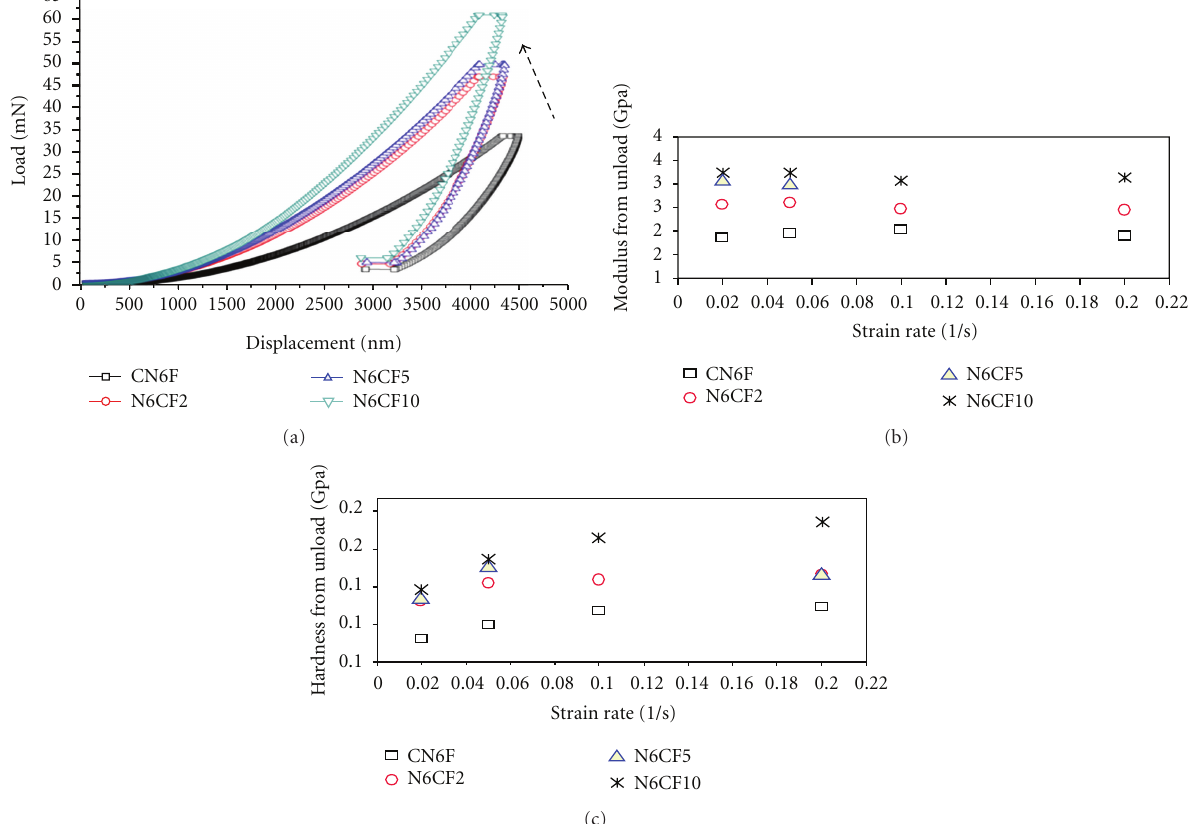
Figure 9: Results of nanoindentation, (a) load-hold-unloading profiles, (b) surface modulus, and (c) hardness for sample (color figure can be viewed in the online